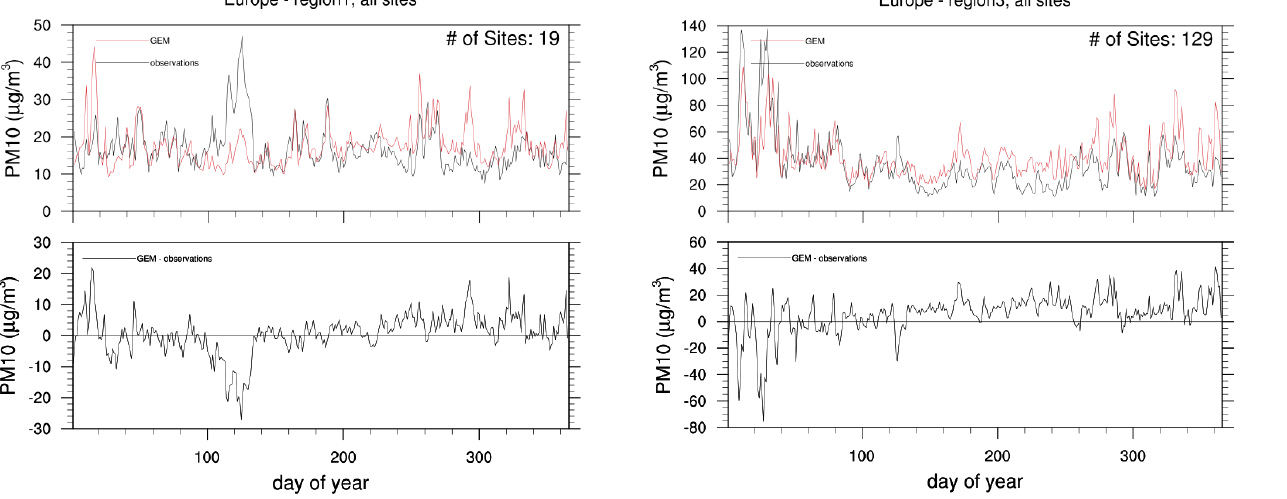
Figure 19. Time series of observed and modelled PM 10 24h con- centration averaged for all stations in northern Europe and MBE.